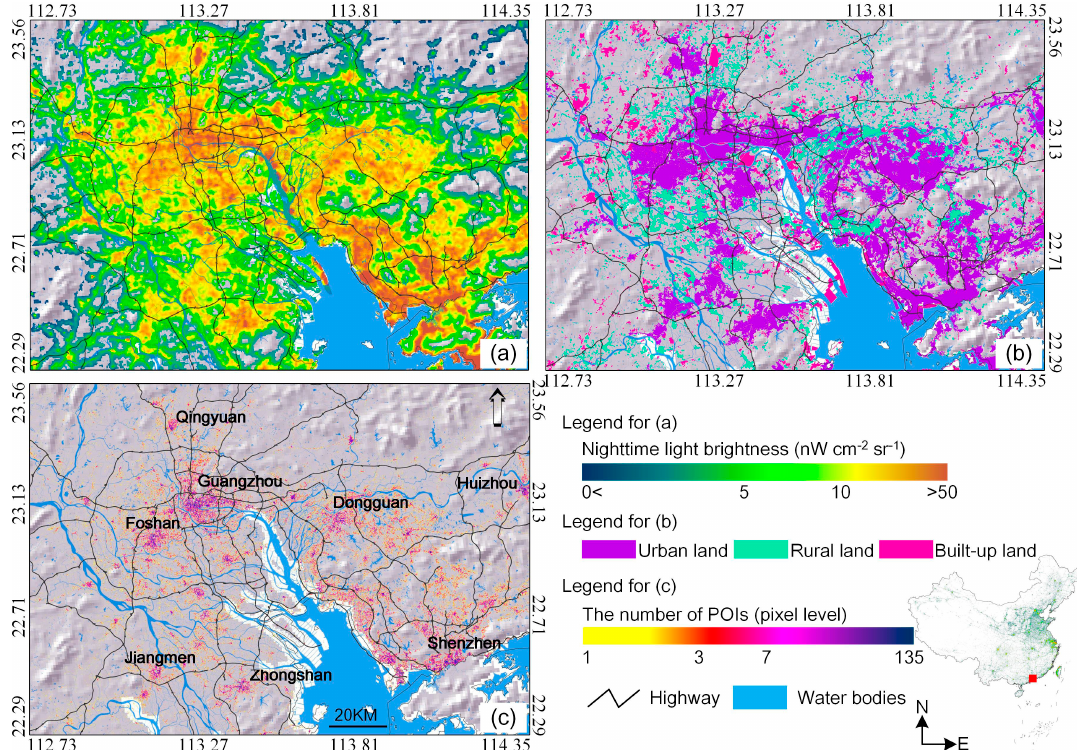
Figure 1. Illustrations of the spatial distributions of three different datasets used in this study as exemplified in the Pearl River Delta region in China (see the inset map). ( a ) Visible Infrared Imaging Radiometer Suite day/night band (VIIRS DNB)-derived nighttime radiance; ( b ) Landsat-derived artificial land; ( c ) Pixel-level density of points of interest (POIs).